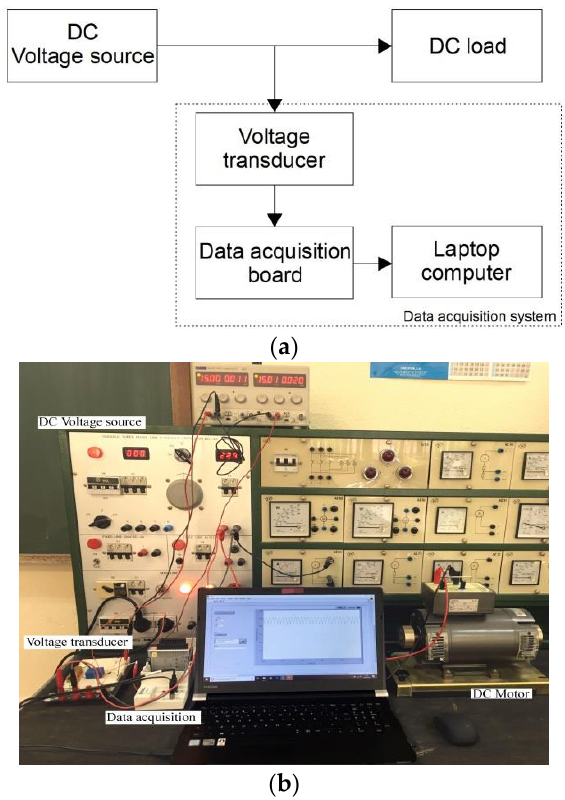
Figure 3. ( a ) Block diagram, and ( b ) laboratory set-up developed for DC power quality